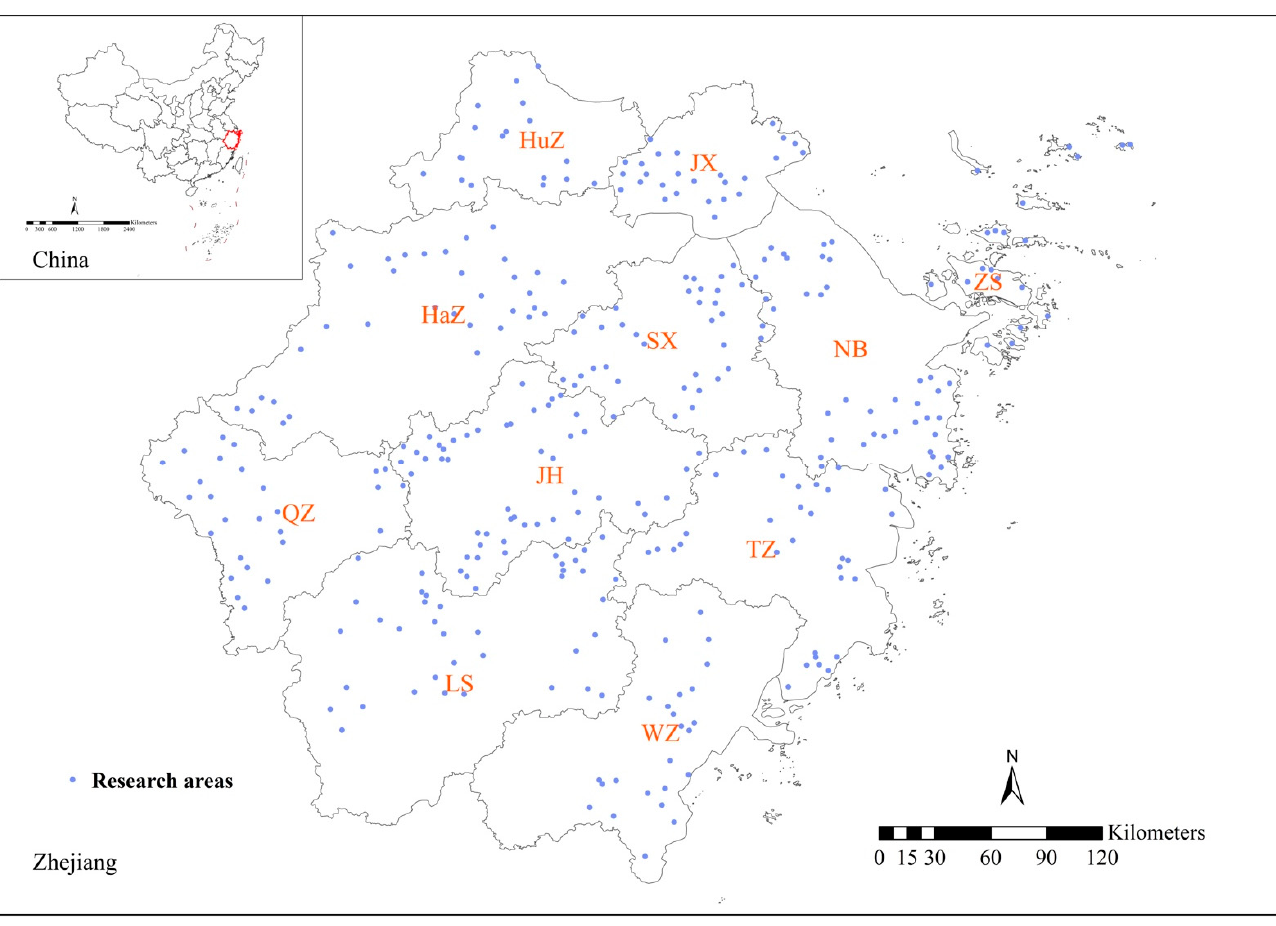
Figure 1. Study area and sampling located townships. (HaZ: Hangzhou, NB: Ningbo, WZ: Wenzhou, JX: Jiaxing, HuZ: Huzhou, SX: Shaoxing, JH: Jinhua, QZ: Quzhou, ZS: Zhoushan, TZ: Taizhou, LS: Lishui).